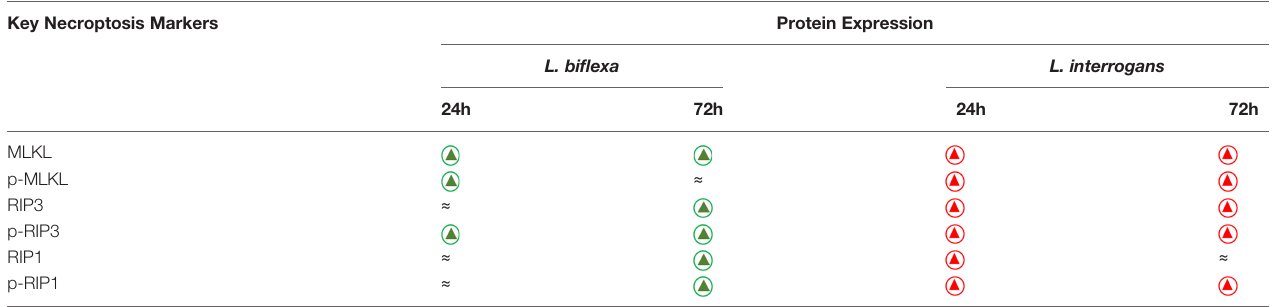
Key Necroptosis